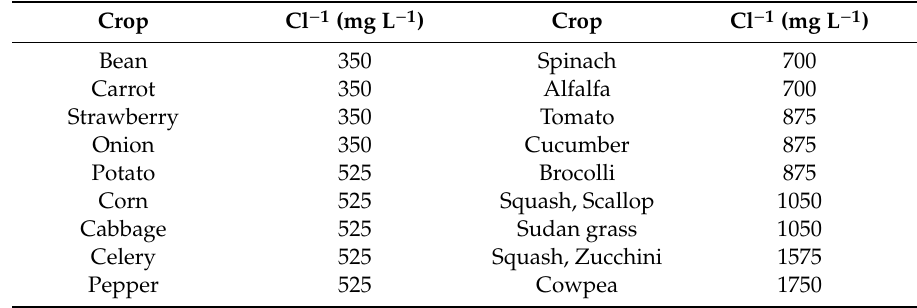
Table 3. Maximum permissible concentrations of chlorides in irrigation water without yield losses (mg L − 1 ). Data adapted from